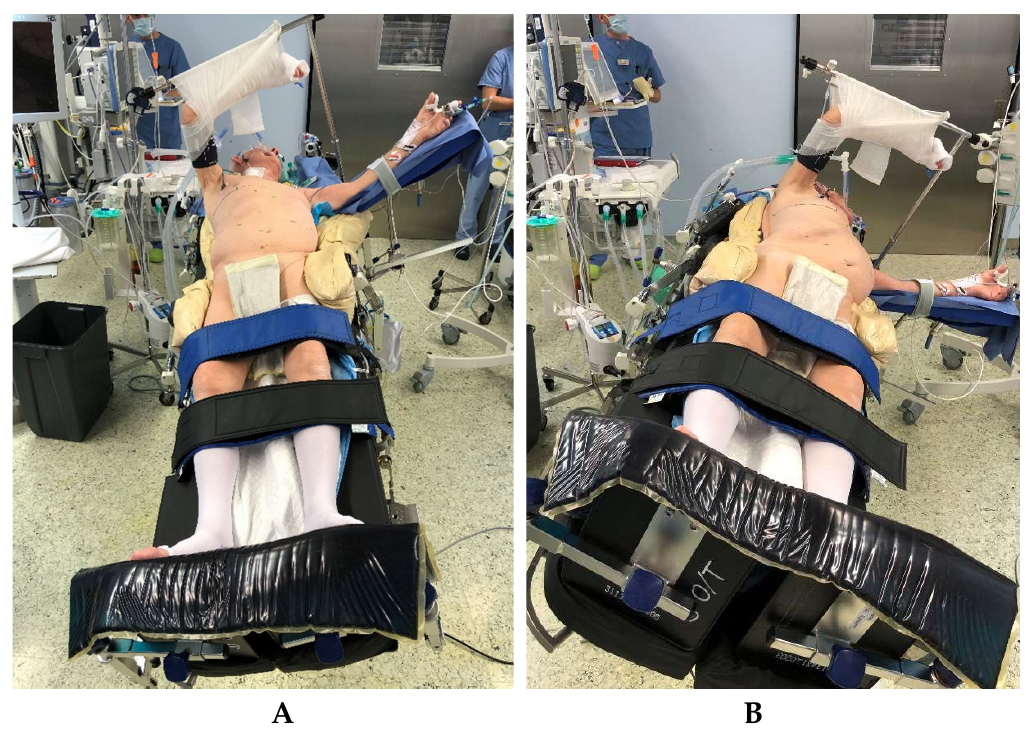
Figure 1. Positioning of the patient on the operating table. A . Position for laparoscopic part of hybrid minimally invasive esophagectomy (HMIE). B . Position for thoracic open part of HMIE.